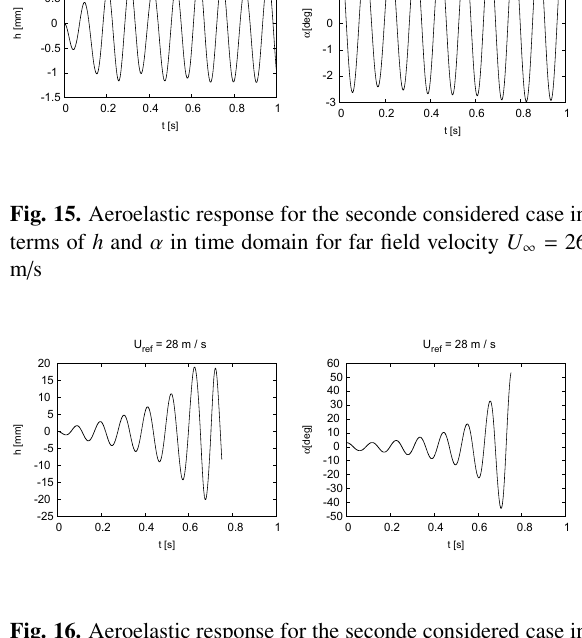
Fig. 16. Aeroelastic response for the seconde considered case in terms of h and α in time domain for far field velocity U ∞ =